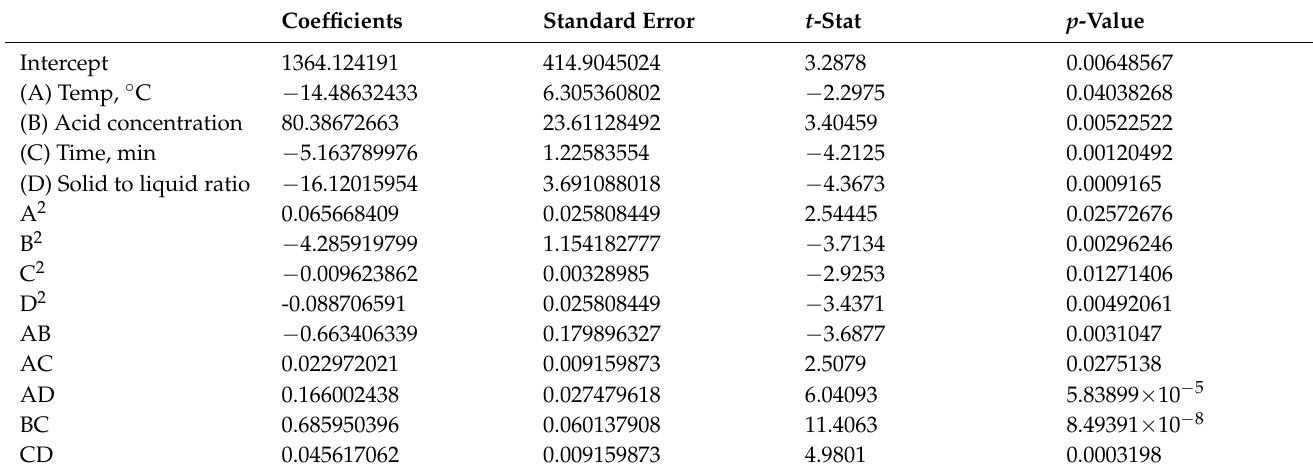
Table 4. Estimated effects on the glucose yield, and regression coefficients of the model.